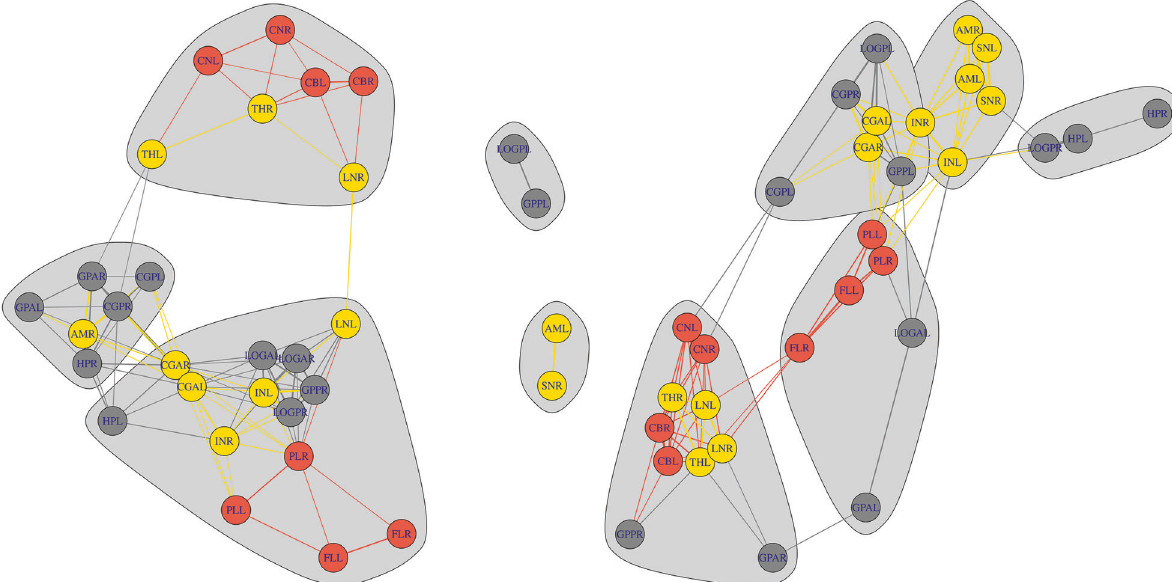
Fig. 5 A schematic representation of the alterations in within- and between-network maturational covariance of preterm-born infants exposed to low (left) and high (right) stress. Gray; default mode network, yellow; salience network, red; executive control network. HPL hippocampus left, HPR hippocampus right, AML amygdala left, AMR amygdala right, GPAL parahippocampal gyrus anterior left, GPAR parahippocampal gyrus anterior right, LOGAL anterior fusiformis left, LOGAR anterior fusiform right, CBL cerebellum left, CBR cerebellum right, INR insula right, INL insula left, GPPR parahippocampal gyrus posterior right, GPPL parahippocampal gyrus posterior left, CGAR cingulate cortex anterior right, CGAL cingulate cortex anterior left, CGPR cingulate gyrus poster right, CGPL cingulate gyrus posterior left, CNR caudate nucleus right, CNL caudate nucleus left, THR thalamus right, THL thalamus left, SNR subthalamic nucleus right, SNL subthalamic nucleus left, LNR lentiform nucleus right, LNL lentiform nucleus left, FLR frontal lobe right, FLL frontal lobe left, PLL parietal lobe left, PLR parietal lobe right, LOGPL posterior fusiform gyrus left, LOGPR, posterior fusiform gyrus right. Network sparsity at